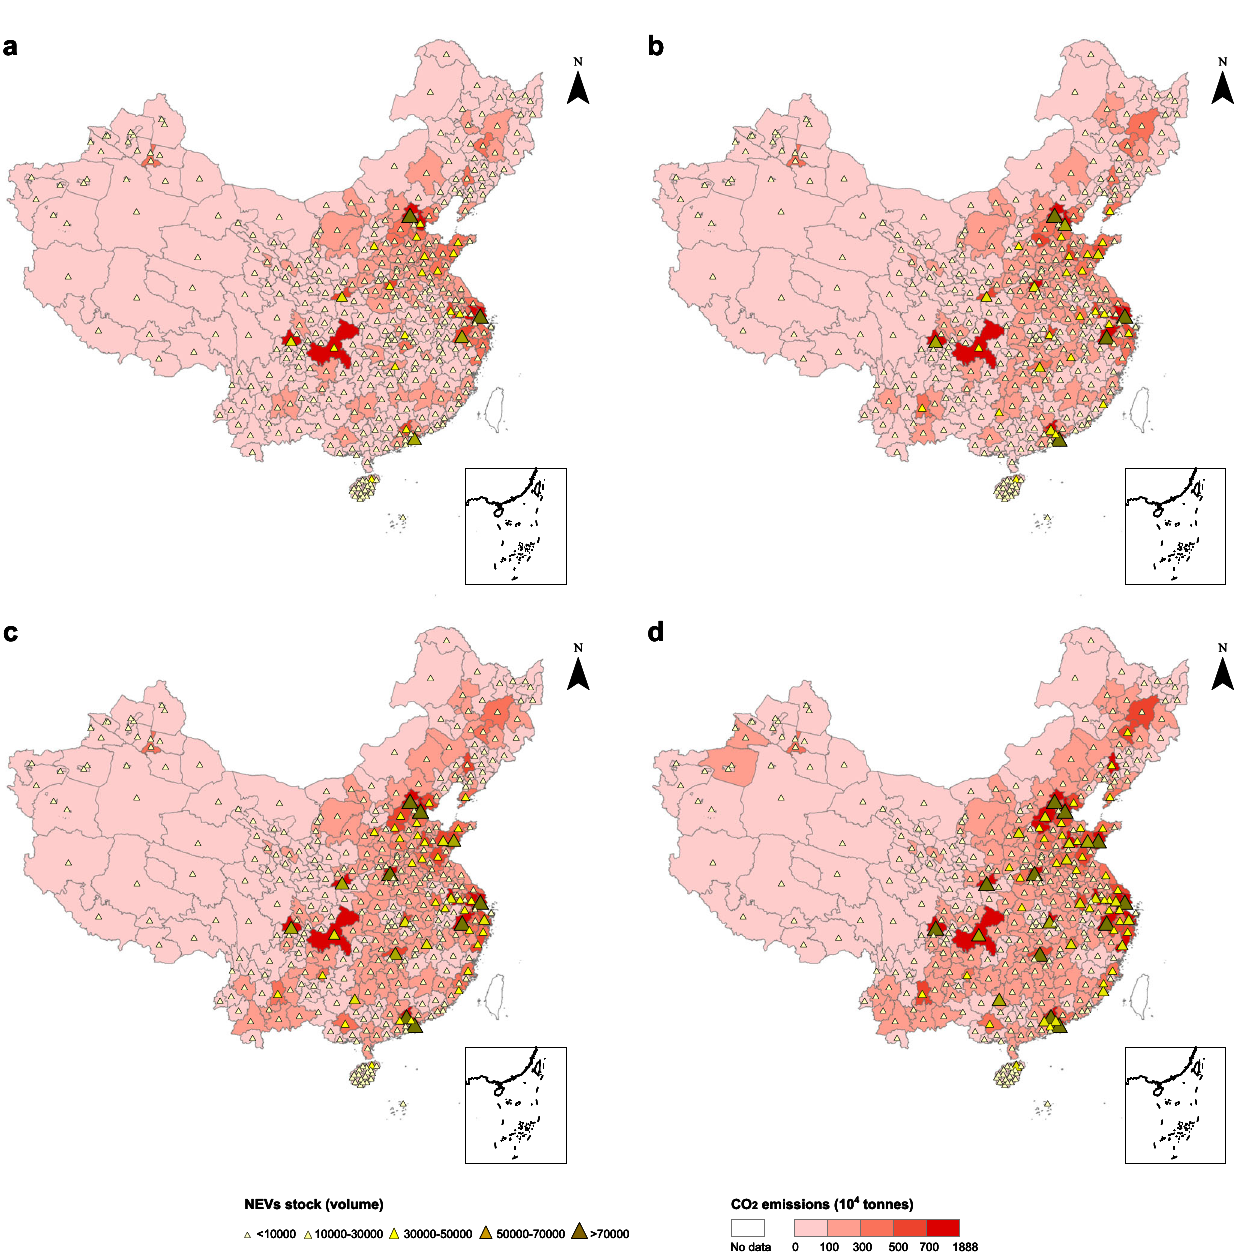
Fig. 2 Distribution of NEV stock and estimation of CO 2 emissions for China passenger road transport 2016 – 2019. a – d (The size and color of the triangle represent the volume of NEV stocks; the background color on the map represents the estimated CO 2 emissions.) Source data are provided in the Source Data fi